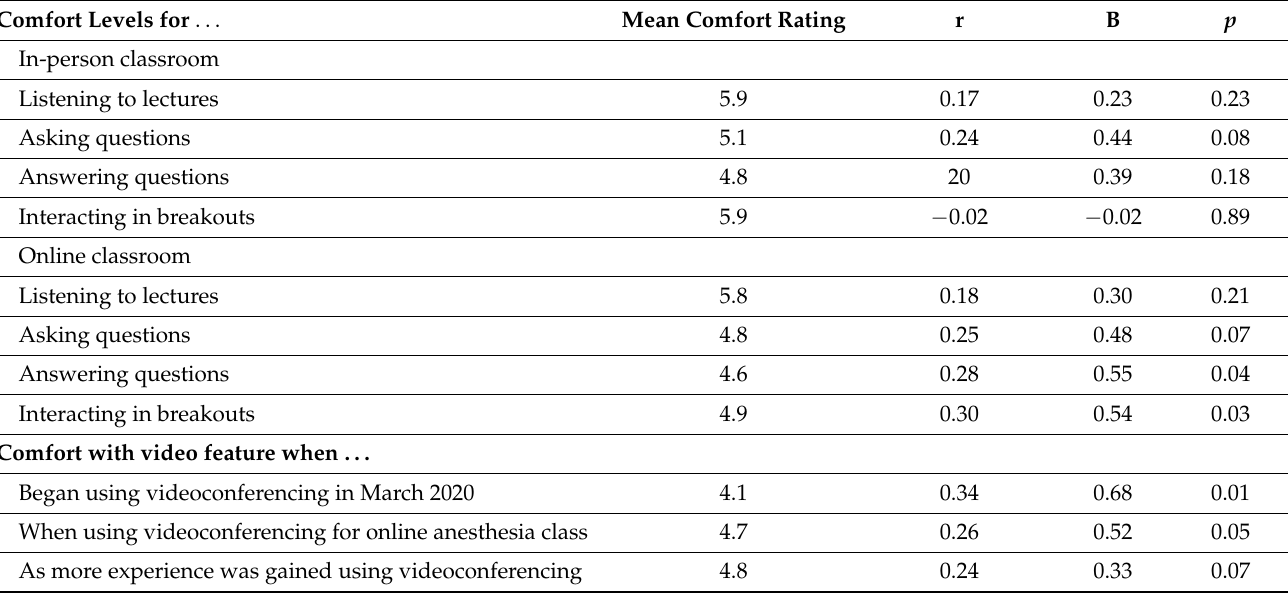
Table 4. Associations * of experience with videoconferencing prior to March 2020 with comfort levels for in-person and online classroom activities, and with the video feature (N =